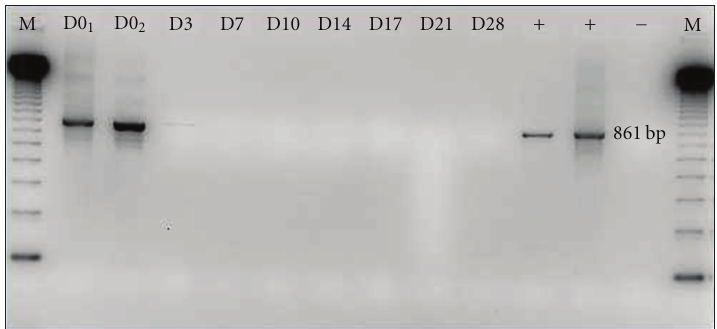
Figure 1: Amplification by nested PCR of Cryptosporidium DNA extracted from stool samples. The gel shows the amplification of a specific 861-bp fragment with specific primers [9]. Lane M: 123-bp DNA size marker ladder; lanes D0 1 and D0 2 (3 days later): samples collected before treatment; lanes D3–D28: samples collected after treatment; +: positive control; − : negative